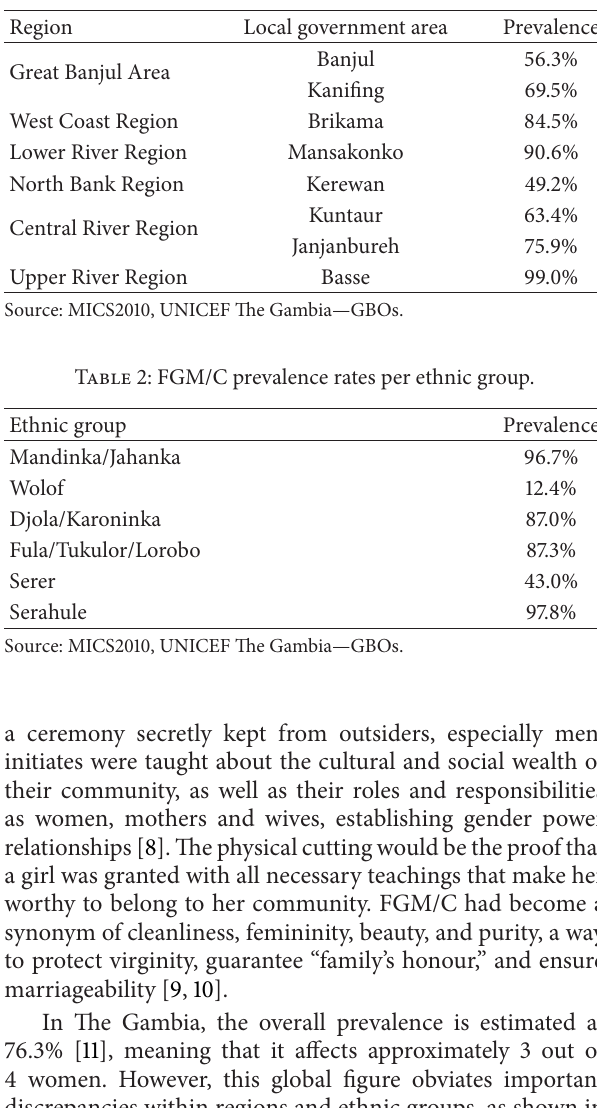
Table 1: FGM/C prevalence rates per region/LGA.